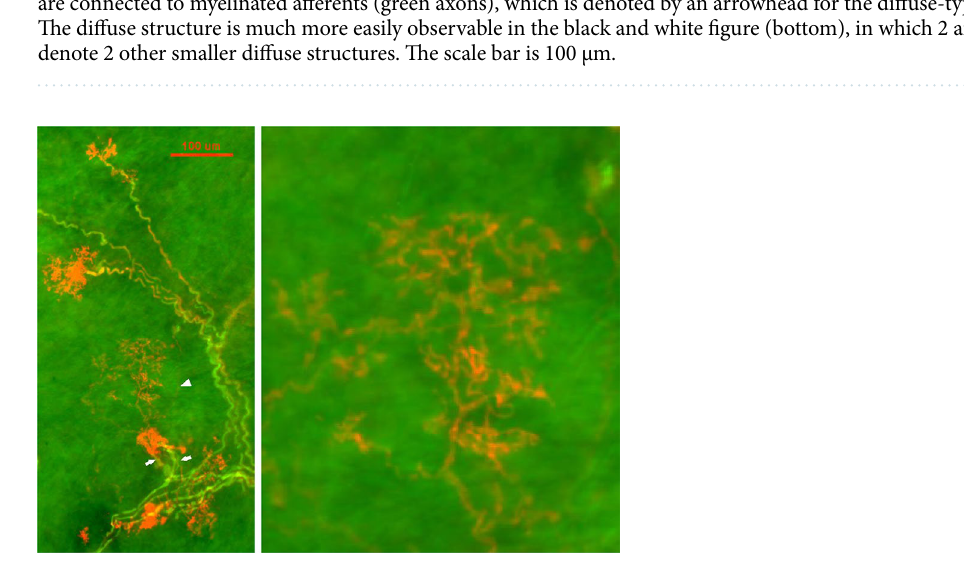
Figure 4. More samples of BR structures with double staining of Na + -K + -ATPase (red) and myelin basic protein (green), showing different types of morphologies. Some are more concentrated round compact type while others are more extended diffuse type. Again, many sensors may share an axon, forming a unit. On the right is the diffuse type found in the middle of the left picture denoted by an arrow head. Two white arrows indicate myelinated axons for a compact type (left) and a diffuse type (right), respectively. The scale bar is 100